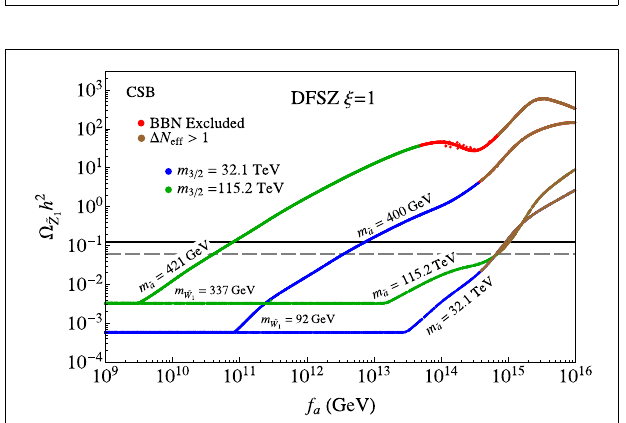
FIGURE 10 | Plot of thermally-produced neutralino abundance (cid:127) vs. m 3 / 2 along the CSB model line with tan β = 10 and µ = 3 TeV.